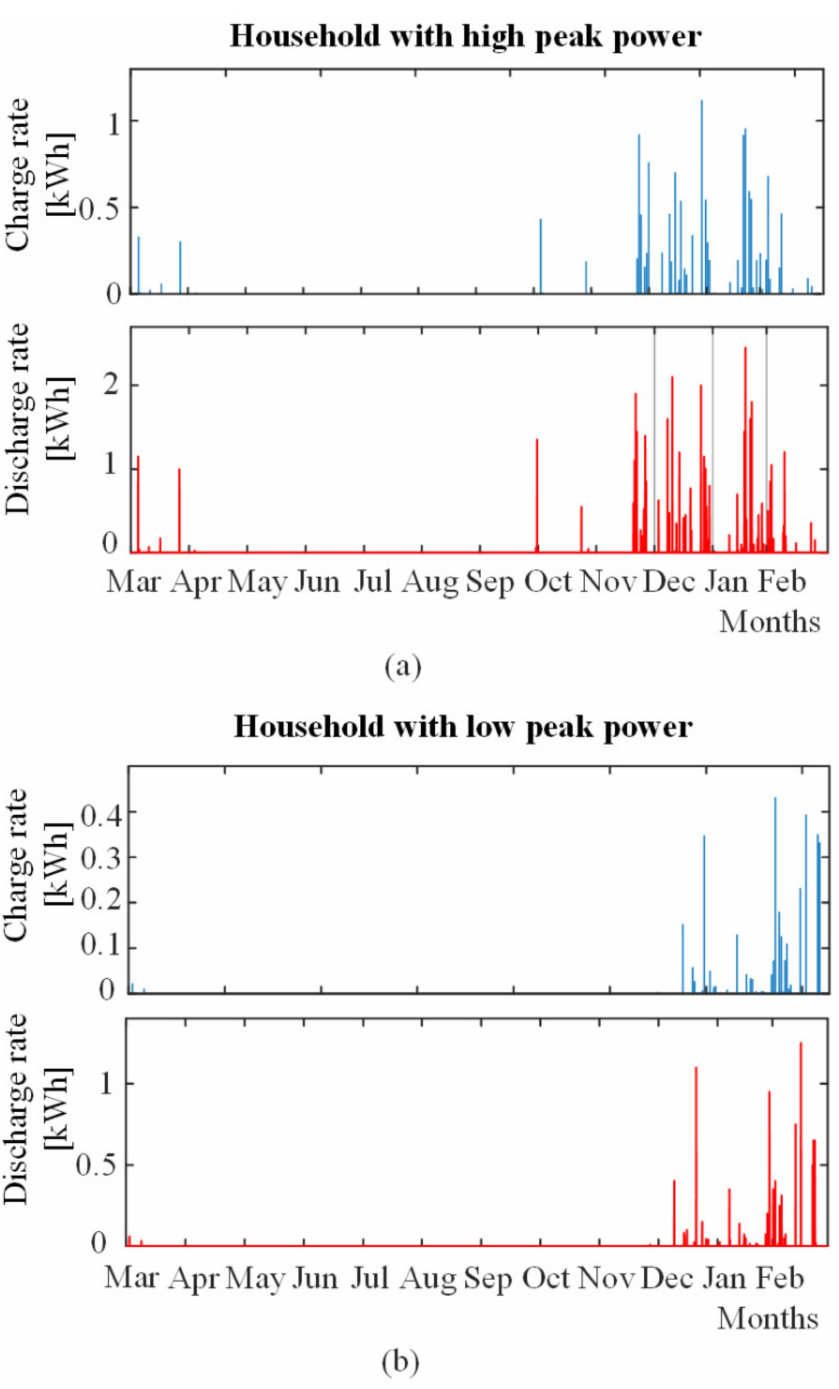
Figure 19. Charging and discharging rates in case of ( a ) high power peak and ( b ) low power